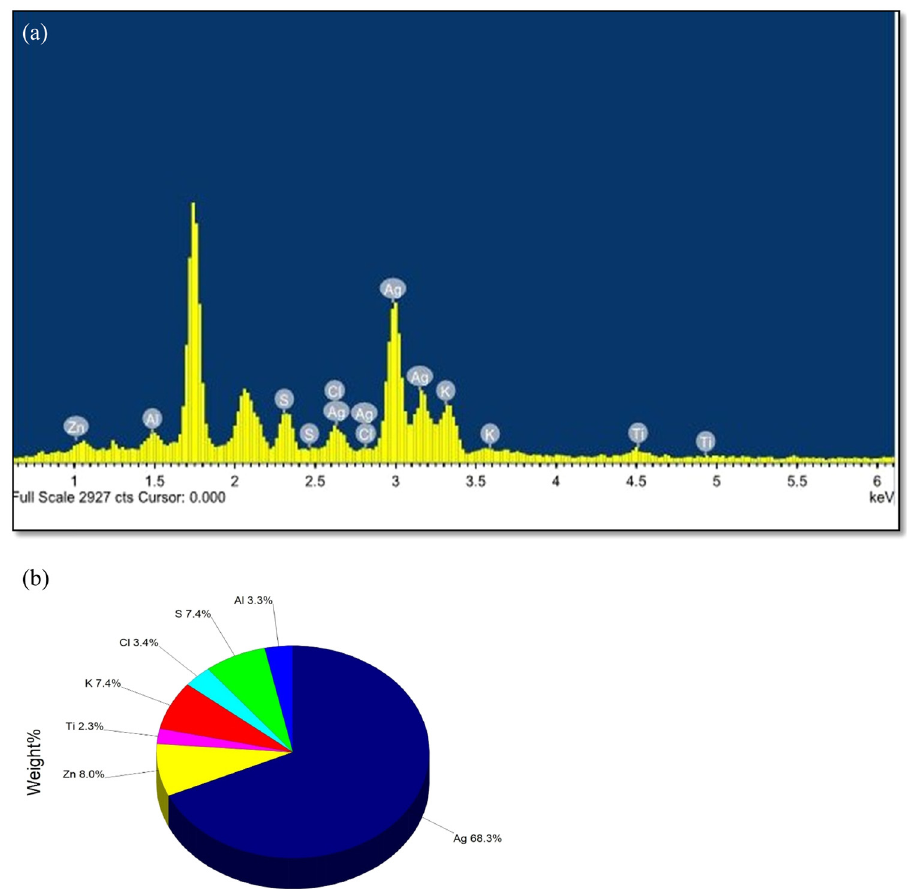
Figure 5: EDX spectrum of the green synthesized Si - AgNPs synthesized from the seeds of S. irio : ( a ) EDX spectrum showing the characteristic silver peak at 3keV and ( b ) the elemental composition of Si -